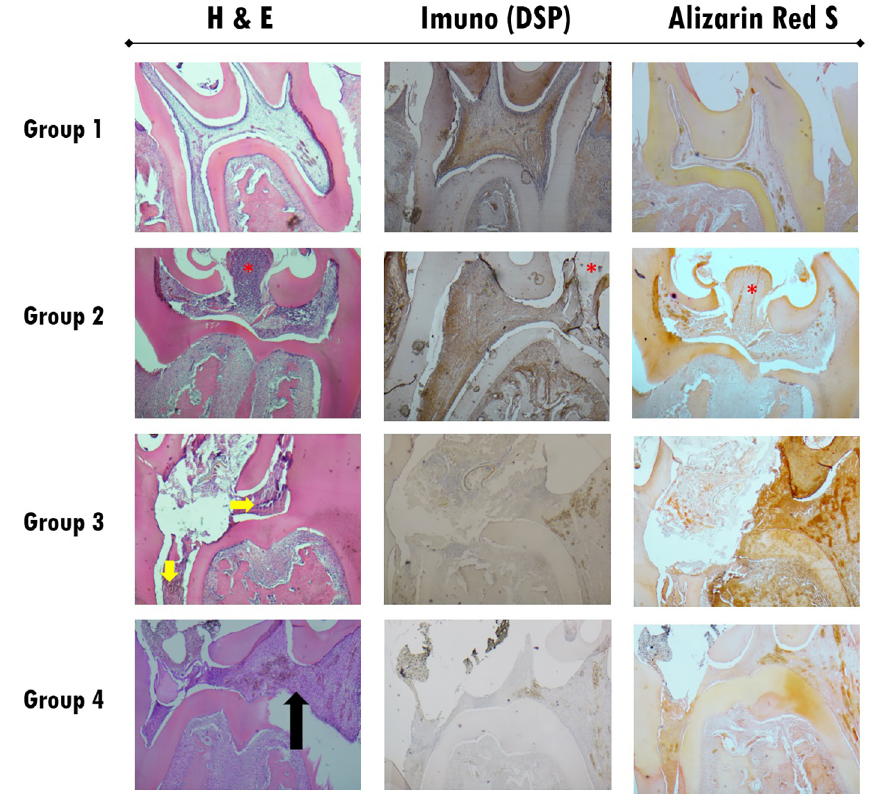
Figure 6- Histological section images of all study groups at three days follow-up, stained with H&E (left column), by immunohistochemistry for DSP (central column) and Alizarin Red S (right column). All images were obtained with 40x magnification. Group 2 shows a pulp polyp formation in the exposure zone without treatment represented by a red asterisk. In Group 3 the presence of the biomaterial used in the extensive exposure zone can be observed, with the presence of intense inflammatory infiltrate (Grade 2) and pulp tissue total disorganization (Grade 2) represented by yellow arrows. Immunohistochemistry images and staining with Alizarin Red S do not show alterations in the presence of DSP or calcium deposits (Grade 0). In Group 4, a slight inflammatory infiltrates (Grade 0) is observed next to the exposure zone (black arrow)